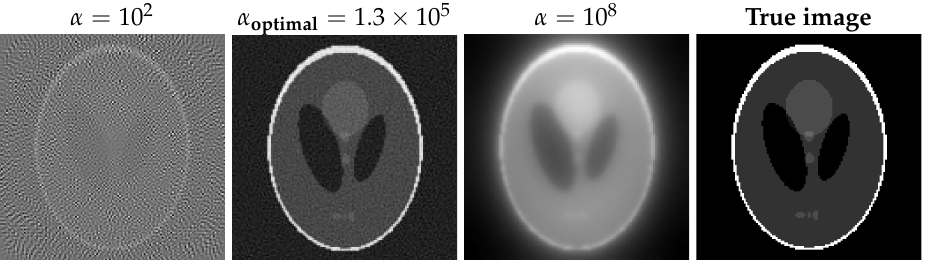
Figure 12. Solutions for X-ray tomography using Tikhonov regularization with regularization param- (cid:8) (cid:9) eters α = 10 2 , 1.3 × 10 5 , 10 8 and the original image (right-most), noise level 1%. Table 3. Relative error (%) of inverse solutions by DIAS and Tikhonov regularization for underregu- larization case with α = 10 2 , noise level 1%.